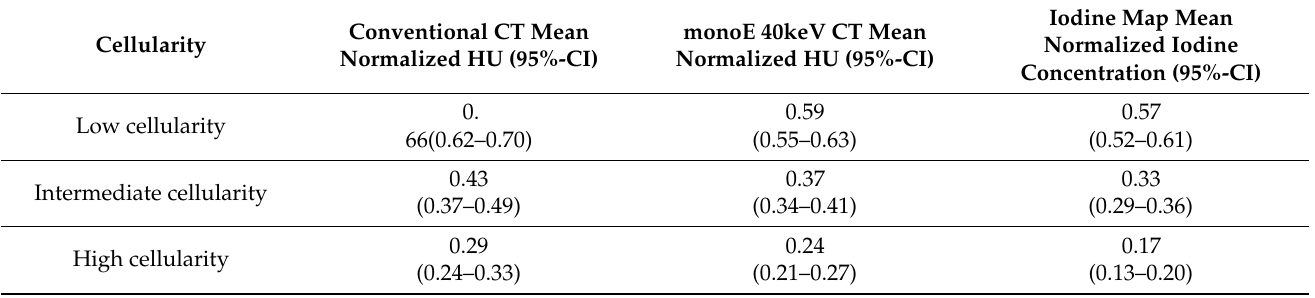
Table 2. Mean HU values, iodine concentrations (normalized for aortic HU and iodine values) and 95%-CI for low, intermediate and high cellularity regions in conventional, monoE 40 keV and iodine map images.